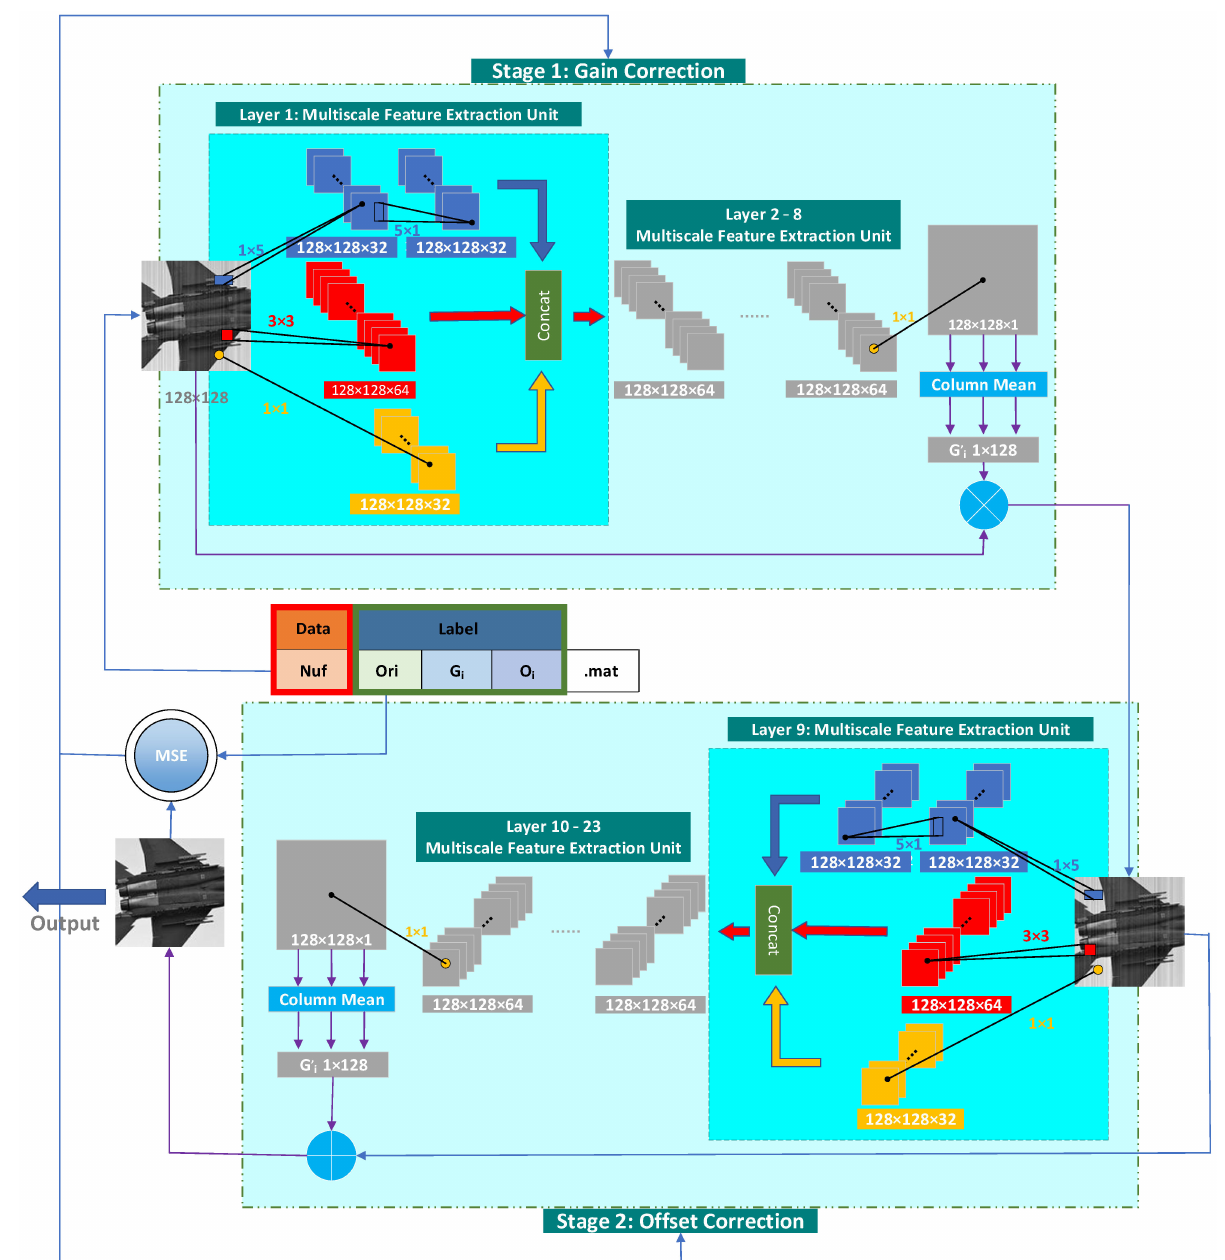
Figure 5. The two-stage deep learning network structure of gain and offset